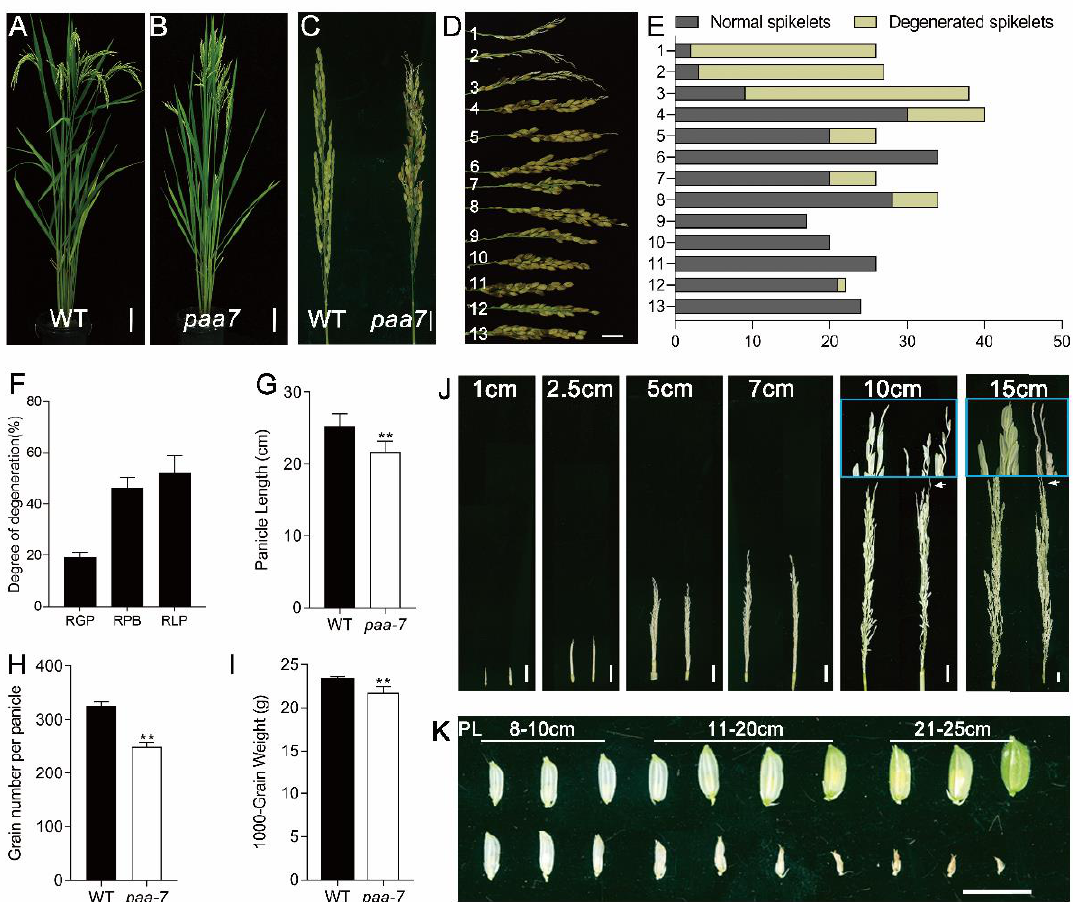
Figure 1. Phenotypic characterization of paa7 . ( A , B ) Morphology of WT and paa7 plants, bars = 10 cm. ( C ) Panicle of WT and paa7 , bars = 2 cm. ( D ) Phenotype of primary branches from one panicle; 1 – 13 indicate primary branches from the top to the bottom of the panicle in paa7 , bar = 1 cm. ( E ) Statistics for the spikelet number correspond to ( D ). ( F – H ) Quantification of panicle length, grain number per panicle, 1000-grain weight. ( I ) Degree of degeneration of paa ; 7 RGP: ratio of degenerated grains per panicle (%), RPB: ratio of degenerated primary branches (%), RLP: ratio of degenerated length per primary branch (%). Error bars indicate standard error. ** p ≤ 0.01 by Student’s t -test, n = 10. ( J ) Representative images of WT (left) and paa7 (right) developing panicles; insets show magnified views of the top of panicles, bars = 1 cm. ( K ) Spikelets of panicles after 8 cm of WT and paa7 ; the number indicates the length of the panicle from which they were collected, bar = 1